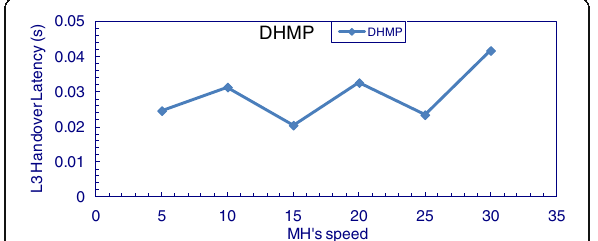
Fig. 13 Impact of MH speeds on the handover delay for the DMHP